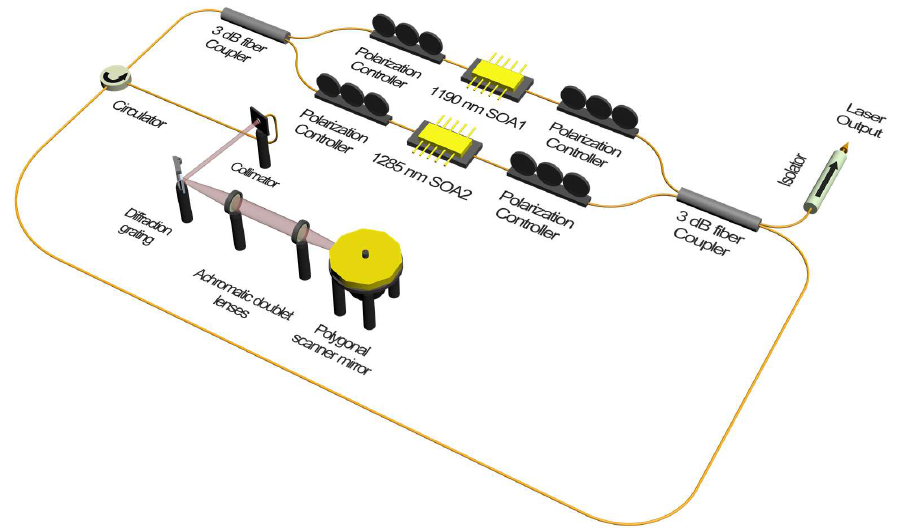
Figure 1. Schematic diagram of experimental setup.